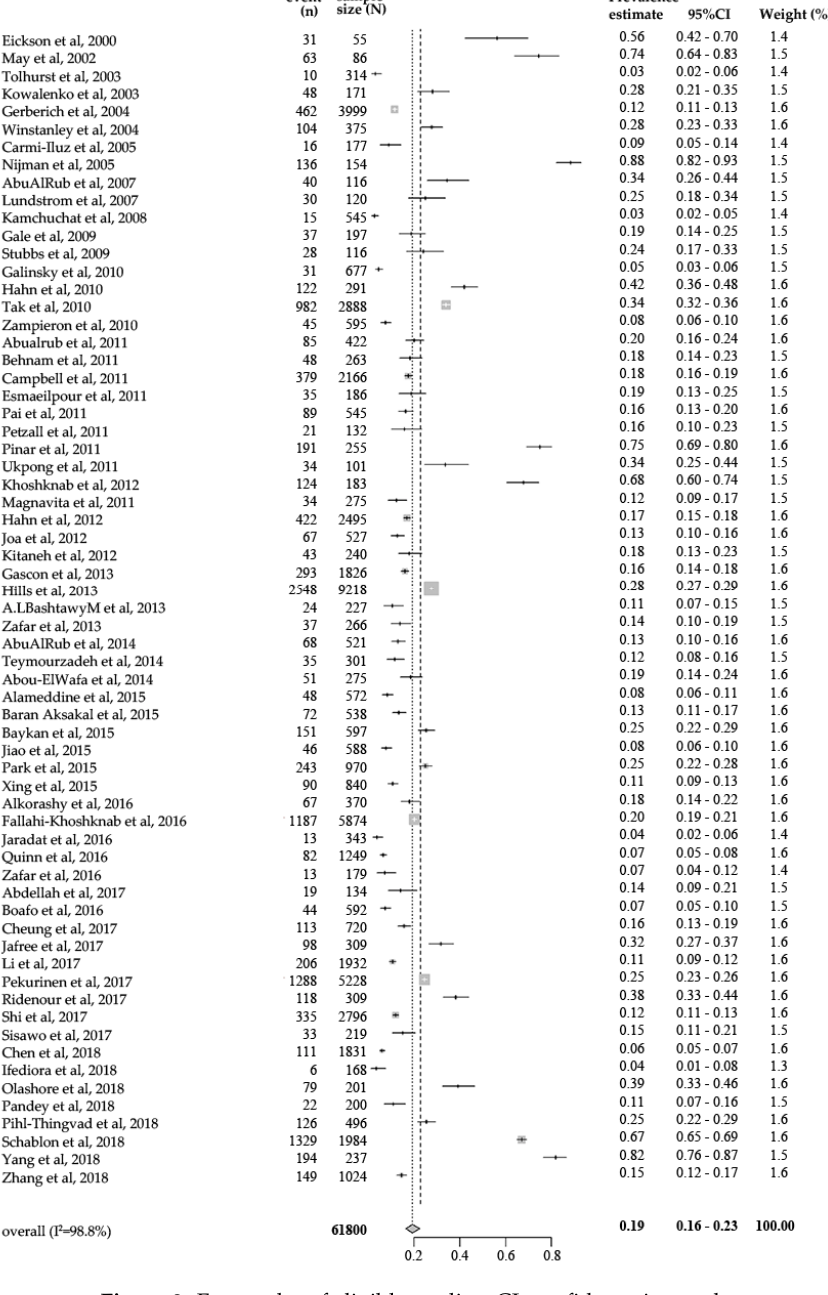
Figure 2. Forest plot of eligible studies. CI, confidence